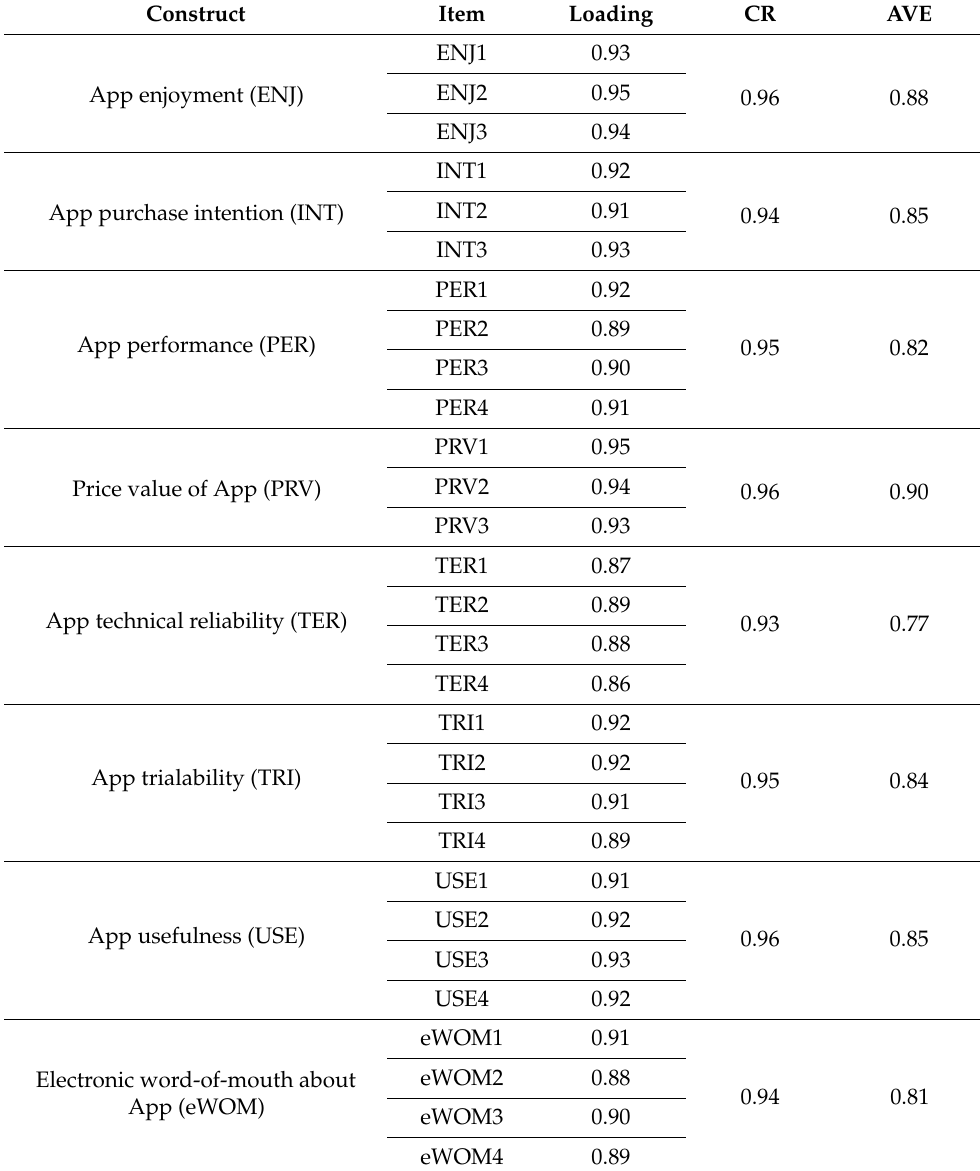
Table 6. Construct reliability and